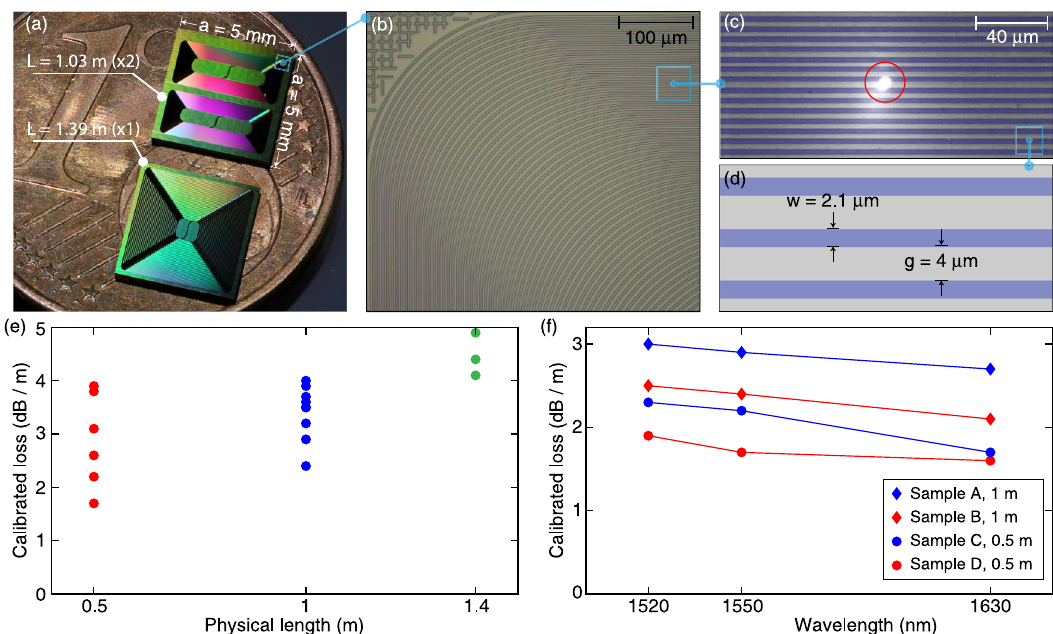
Fig. 4 Small-footprint, meter-long, ultralow-loss Si 3 N 4 spiral waveguides. a Photograph showing Si 3 N 4 chips containing two 1.0-meter-long and one 1.4- meter-long spiral waveguides. b , c Optical micrographs of the densely packed Si 3 N 4 waveguides in Archimedean spirals, taken with a yellow light camera ( b ) and IR camera ( c ). When 1550 nm laser light is coupled into the waveguide, light-scattering defects are observed under the IR camera (highlighted with a red circle). d Schematic showing the waveguide width and spacing. e Measured and calibrated optical losses at 1550 nm wavelength in 0.5 m, 1.0 m, and 1.4 m long spiral waveguides. f Measured and calibrated losses at different wavelengths for four selected